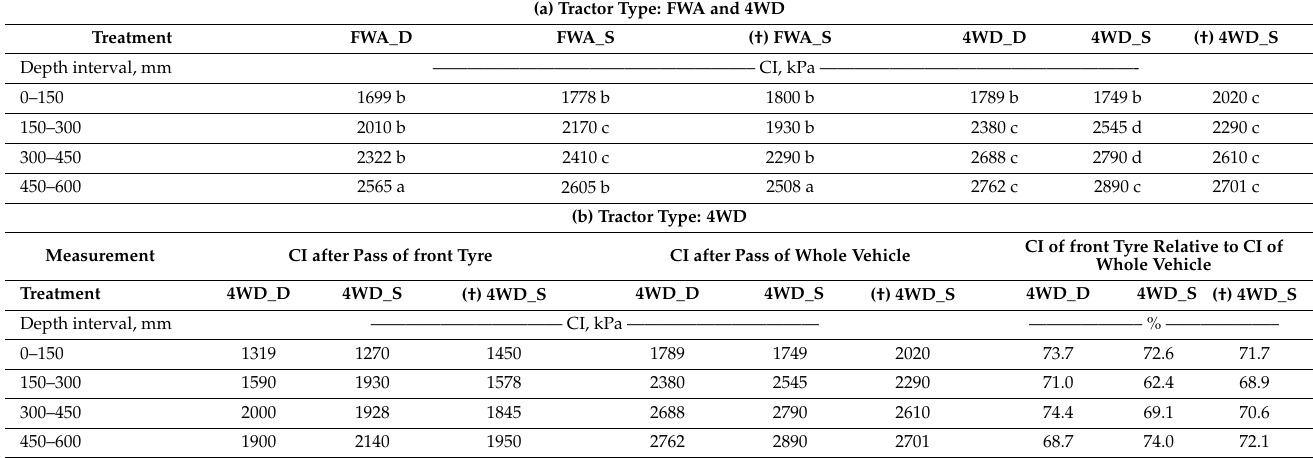
Table 3. (Top): Summary of soil cone index (CI) data recorded after single-pass tests with the FWA and 4WD tractors used in this study. Different letters horizontally indicate that mean values are significantly different ( p < 0.05). Description of tractors and treatments’ notation are as shown in the caption of Table 2. (Bottom): Summary of soil cone index (CI) data recorded after driving the front tyres and the whole vehicle (front and rear tyres) over the soil, and the CI of front tyres expressed as a percentage of the CI recorded after the pass of the whole vehicle. Single-pass tests performed with the 4WD tractor. Description of the 4WD tractor and treatments’ notation are as shown in the caption of Table 2.